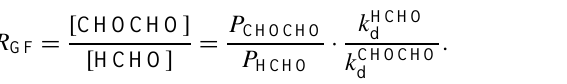
Figure 5. Time series of modeled R GF (by the model base case), measured NO and NO 2 concentrations and NMHC compositions for the 6 cloud-free days during the PRIDE-PRD2006 campaign. The NMHC composition is expressed as the fraction of OH reactivity of a certain type of NMHC to that of the total NMHC.